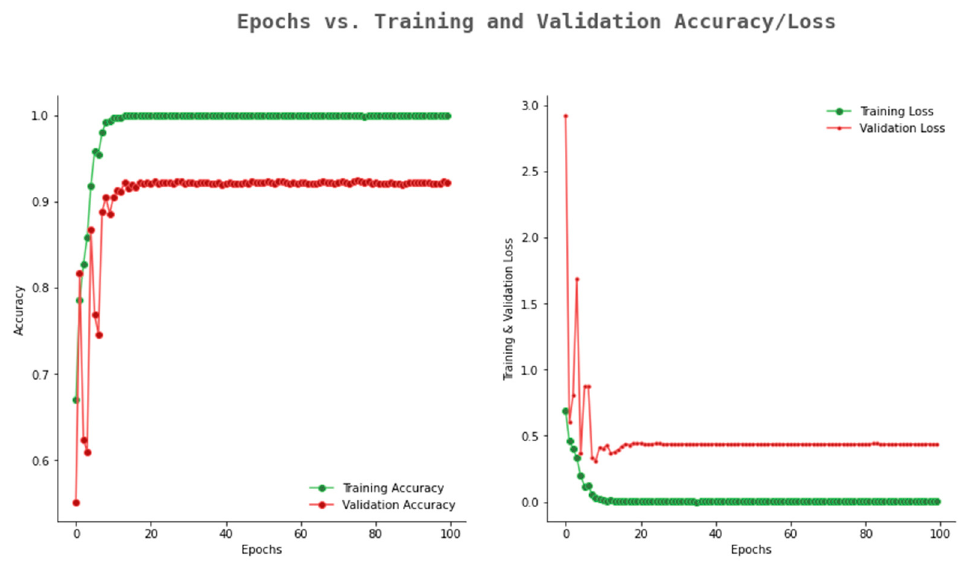
Figure 10. Accuracy and loss graph of ResNet50.